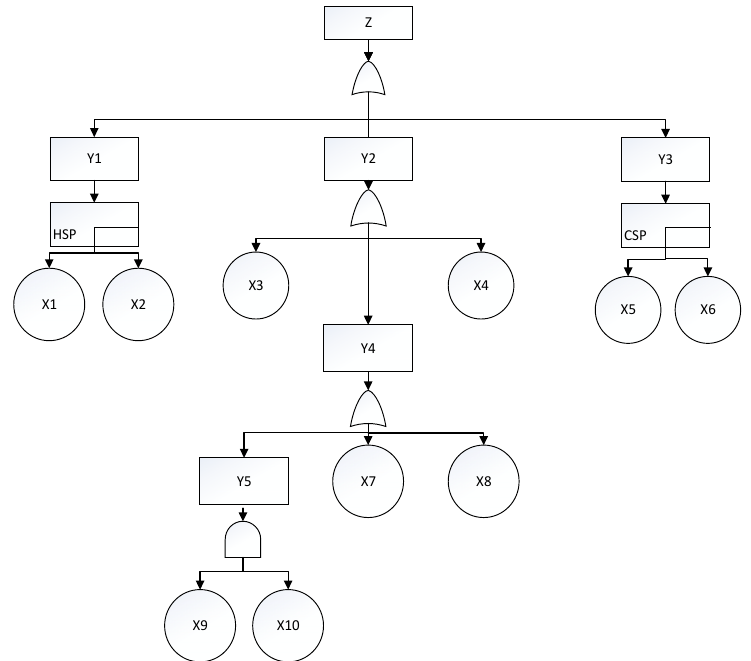
Figure 2. Dynamic fault tree of automotive airbag system.